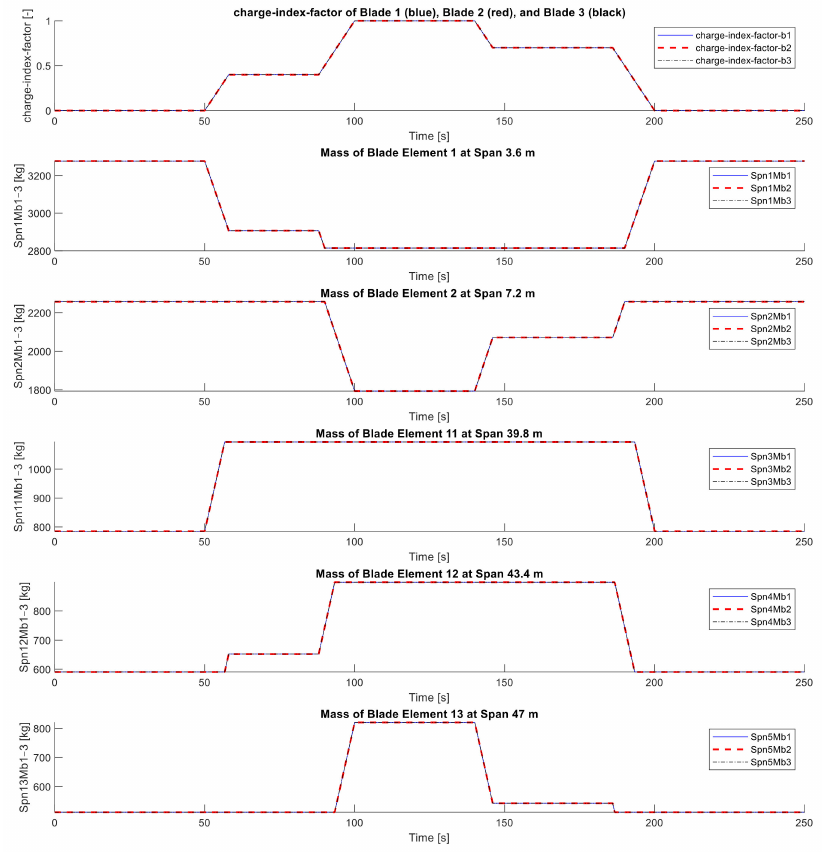
Figure 5. Mass change of blade element 1, 2, 11, 12 and 13 depending on the charge-index-factor of each rotor